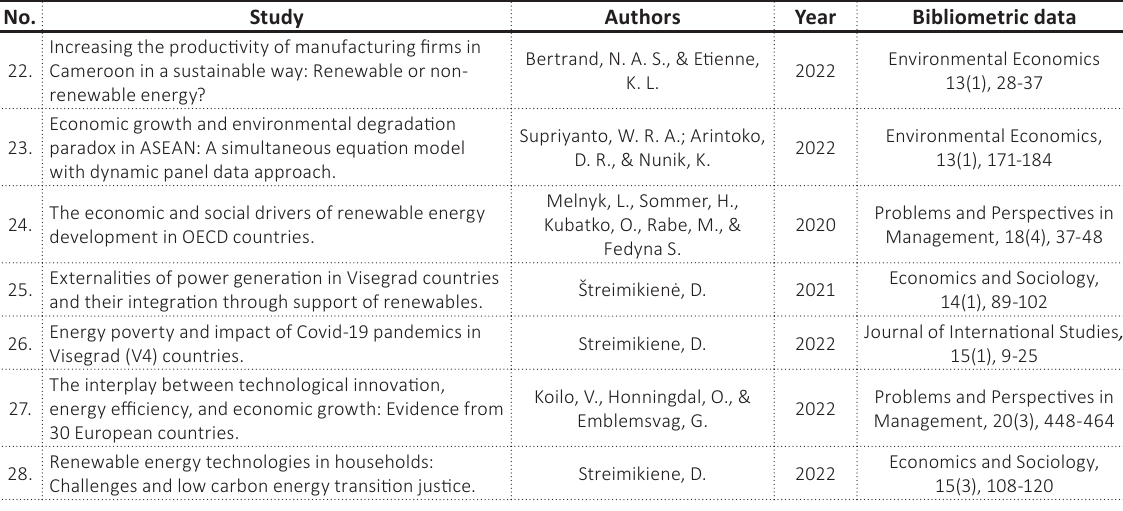
Table E2. List of papers based on a bibliometric map of publications related to SDG 7 and COVID-19 No.